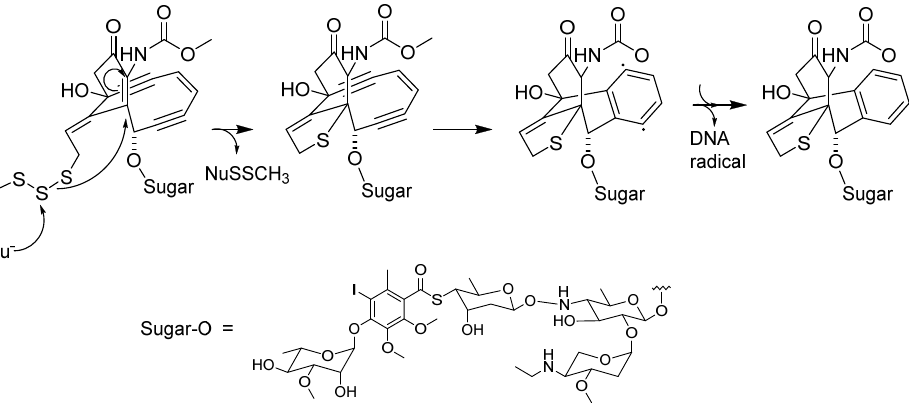
Figure 2. Examples of payloads in